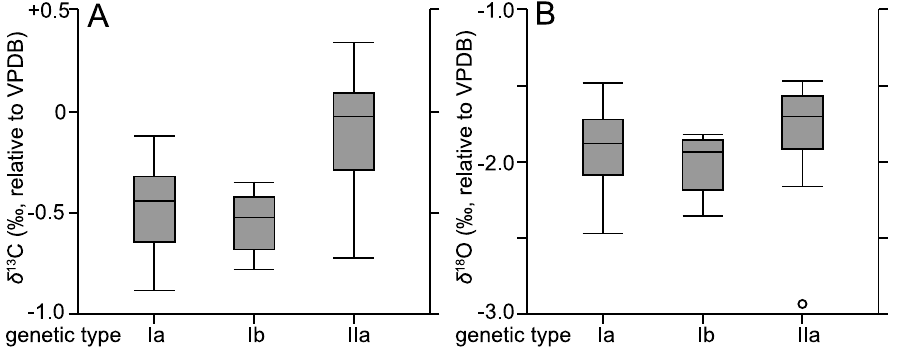
Fig 6. ANOVA results of δ 13 C and δ 18 O in three genetic types (Ia, Ib, and IIa) of Globigerinoides ruber . Values for δ 13 C and δ 18 O are shown on the left (6A) and right (6B), respectively (i.e., n = 16 for genetic type Ia, n = 8 for genetic type Ib, and n = 10 for genetic type IIa). Individual open circles correspond to